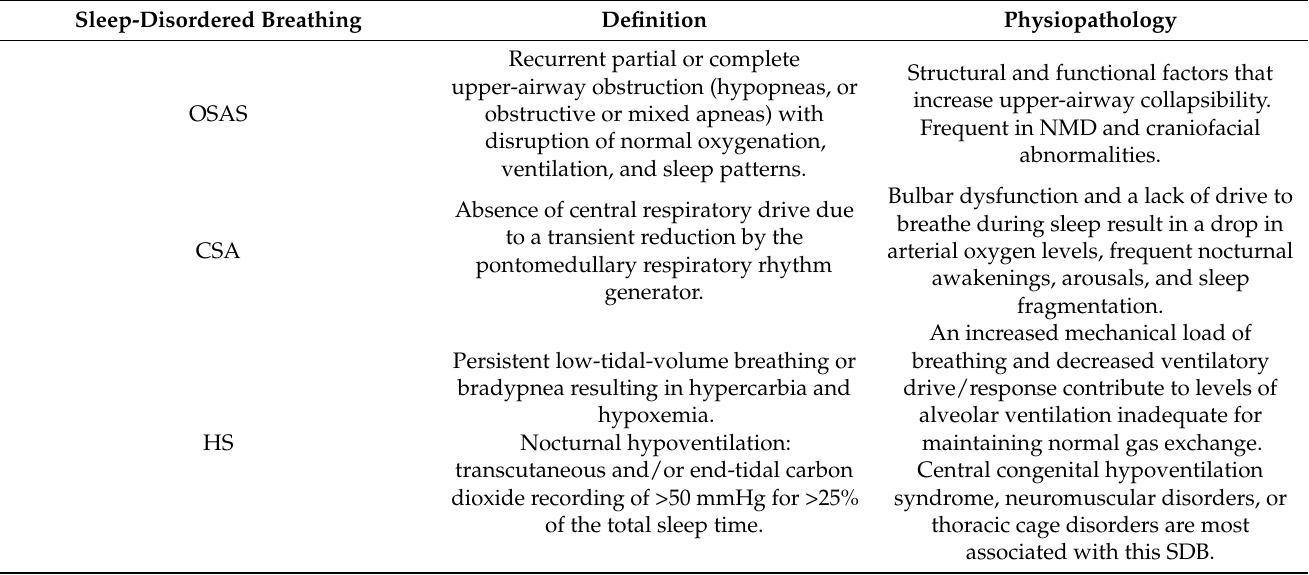
Table 1. Sleep-disordered breathing in